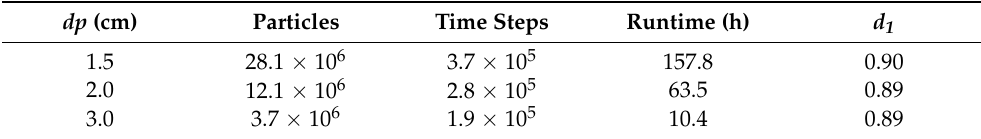
(b) Figure 12. Block diagrams for the dynamic response of the WEC with an open-loop system ( a ) and a closed-loop system ( b ). To search the space of controller gains for the optimal tuning around a predicted value, the proportional and integral gains vary every 45 s during the physical experiment. In this section, however, a time window where the gains remain constant is selected from the physical experiment [57]. In particular, t ∈ (271,316) is considered, where the actuator